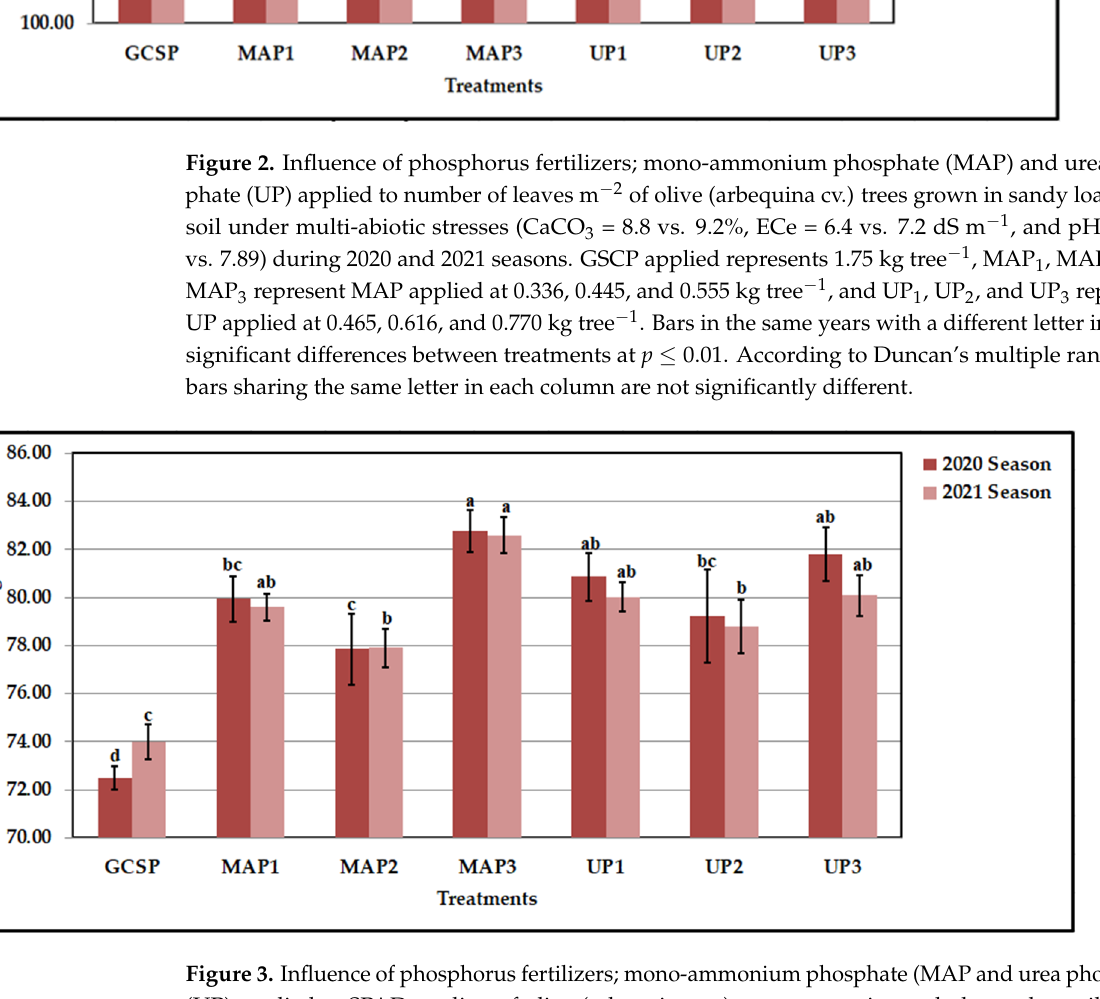
Figure 3. Influence of phosphorus fertilizers; mono-ammonium phosphate (MAP and urea phosphate (UP) applied to SPAD reading of olive (arbequina cv.) trees grown in sandy loam clay soil under multi-abiotic stresses (CaCO 3 = 8.8 vs. 9.2%, ECe = 6.4 vs. 7.2 dS m − 1 , and pH = 7.78 vs. 7.89) during 2020 and 2021 seasons. GSCP applied represents 1.75 kg tree − 1 , MAP 1 , MAP 2 , and MAP 3 represent MAP applied at 0.336, 0.445, and 0.555 kg tree − 1 , and UP 1 , UP 2 , and UP 3 represent UP applied at 0.465, 0.616, and 0.770 kg tree − 1 . Bars in the same years with a different letter indicate significant differences between treatments at p ≤ 0.01. According to Duncan’s multiple range test, bars sharing the same letter in each column are not signi fi cantly different .